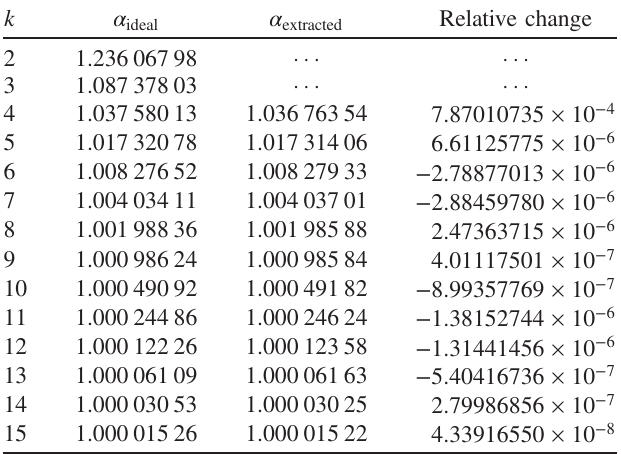
TABLE I. Feller ’ s coin tossing constants. The constants are related to the probability that a certain sequence of 1 ’ s does not occur in a set of random bits. Here, the sample size is N ¼ 400 . The ideal value of the coin tossing constant α is compared to the values extracted from our experimental data. Relative change is − α = α calculated as ð α . The relative uncertainty is ideal extracted Þ ideal given by the finite length of the acquired data